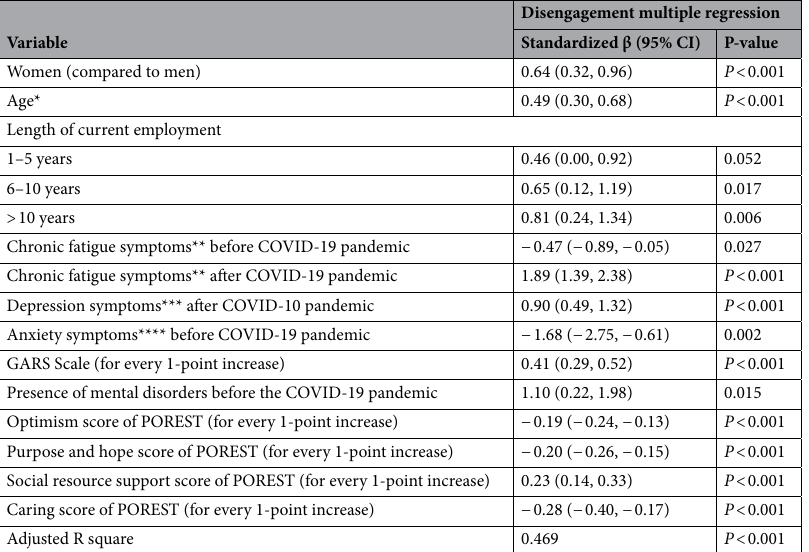
Table 10. Multiple linear regression analyses predicting disengagement score. CI confidence interval, GARS global assessment of recent stress scale, POREST positive resources test. *60 years and older, 50–59